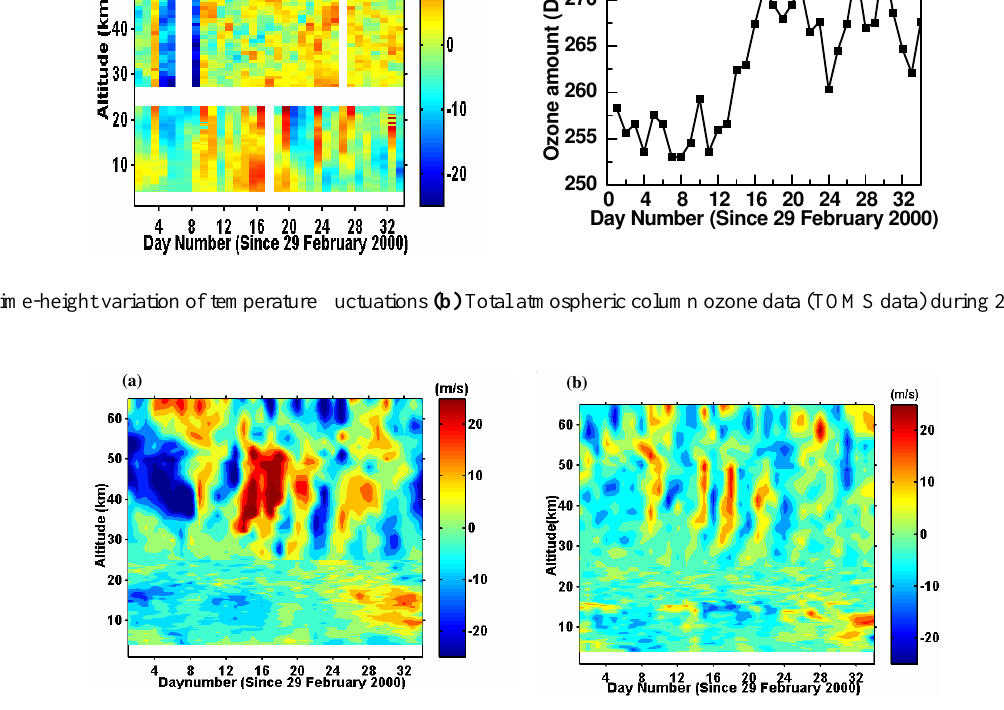
Fig. 2. Time-height section of (a) zonal and (b) meridional wind fluctuations during February 29 to April 2, 2000.